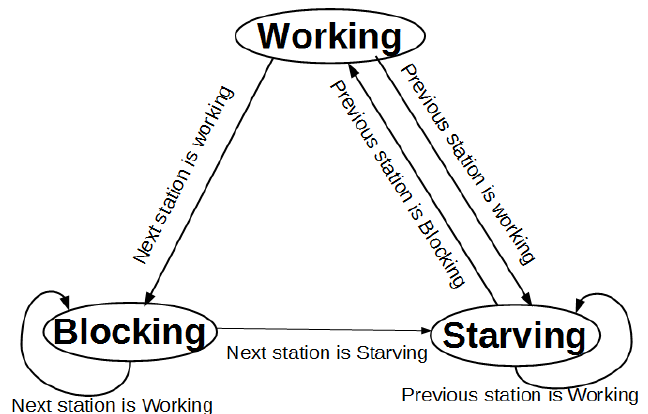
Figure 2. Schema for the different station states in a production